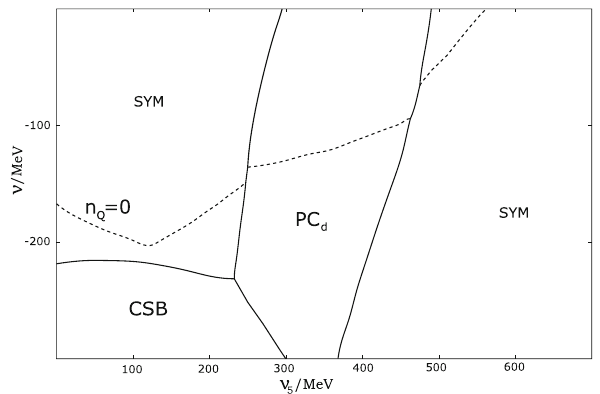
Fig. 10 The (ν 5 ,ν) -phase diagram of β -equilibrium quark matter (see the models (7), (8)) at μ = 400 MeV and μ 5 = 400 MeV in the chiral limit, m 0 = 0. All the notations are the same as in Figs. 1, 2 and